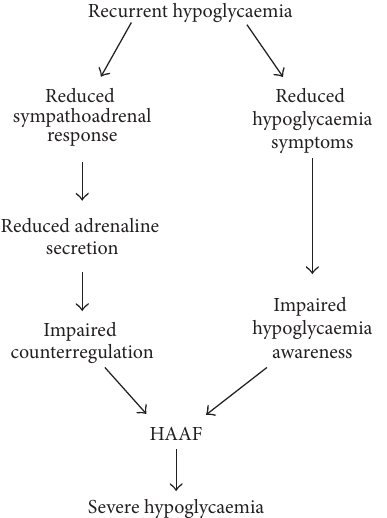
Figure 2: Recurrent hypoglycaemia leads to impaired adrenom- edullaryadrenalineresponseandreducedhypoglycaemiasymptoms giving rise to the phenomenon of HAAF, which predisposes an individual to become more vulnerable to severe